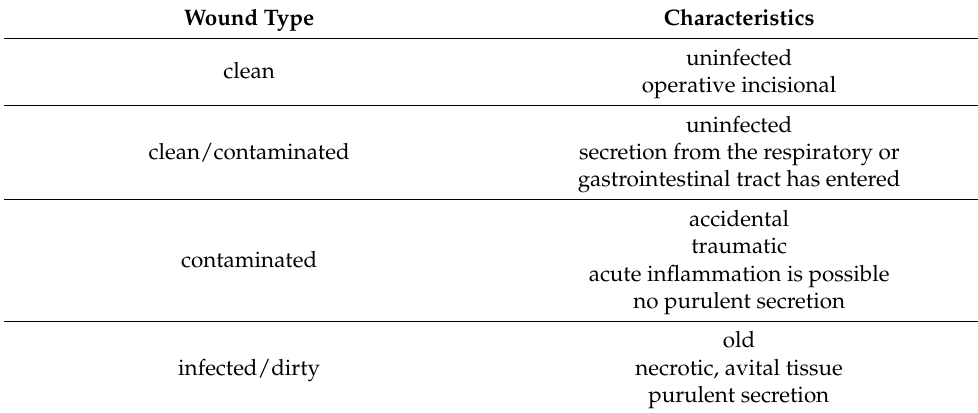
Table 1. Classification of